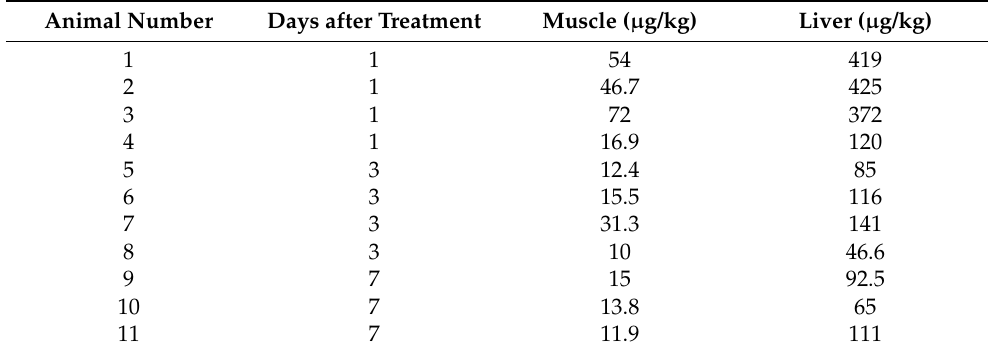
Table 3. Values found in rabbits for tiamulin marker residues (dose 12,000 µ g tiamulin/kg body weight/day for 7 days).